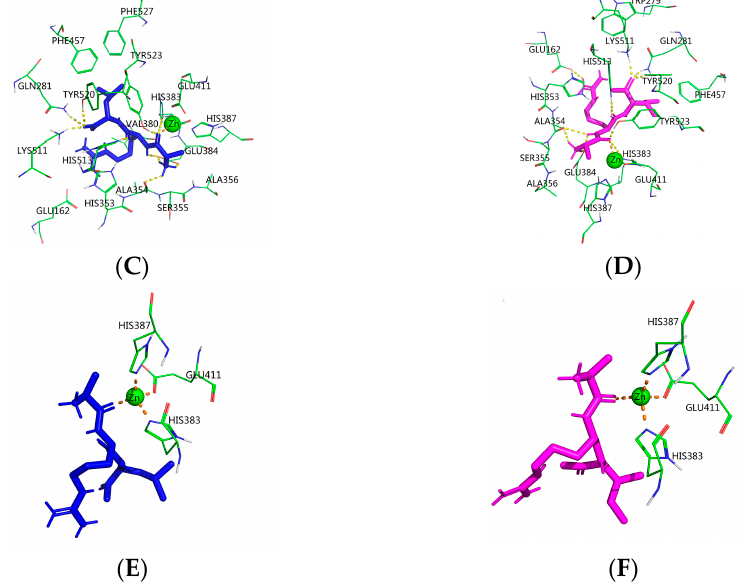
Figure 6. Molecular docking between ACE and ARL/I. General overviews of docking pose of ARL and ARI at the ACE site are shown in ( A , B ), respectively. The blue stick mode is ARL; the magenta stick mode is ARI. ( C , D ) mean details of the interaction between ACE and peptide ARL and ARI, respectively. The hydrogen bonds are shown in yellow dashed lines and zinc coordination bonds are in oranges dashed lines. Schematic views of ARL – and ARI – zinc coordination at the ACE active site are indicated in ( E , F ), respectively. Table 4. Hydrogen bonds observed between best bioactive peptide poses obtained from docking results and